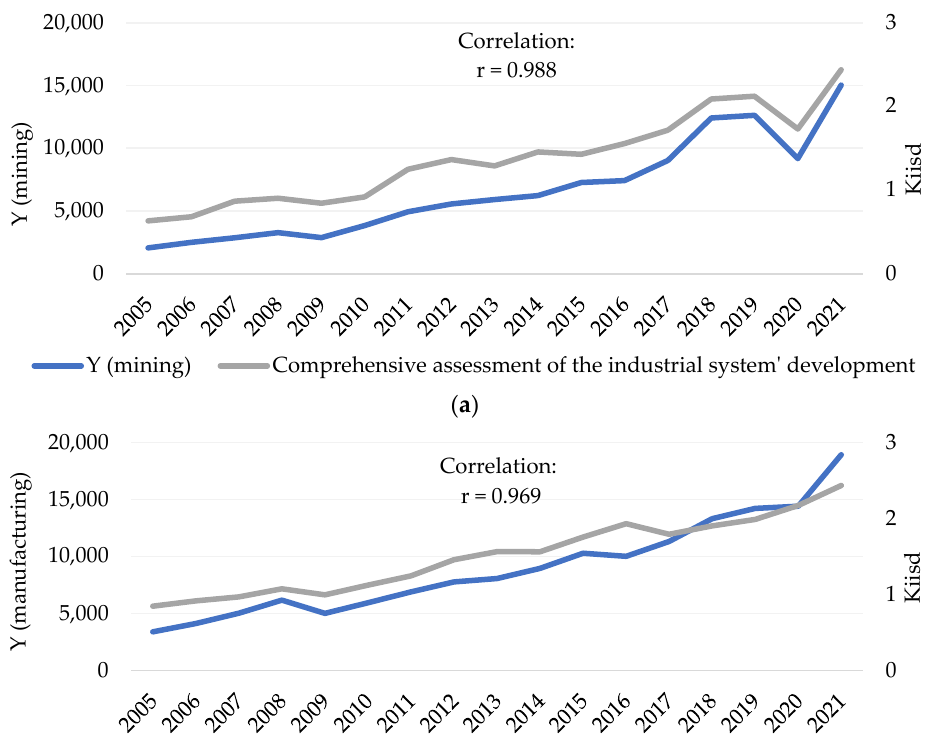
Figure 4. The verification coefficient of development effectiveness the innovation industrial system for the mining ( a ) and manufacturing ( b ) industries (comparison of the actual values of gross value added and calculated by the author’s methodology values of the coefficient of development of innovative industrial